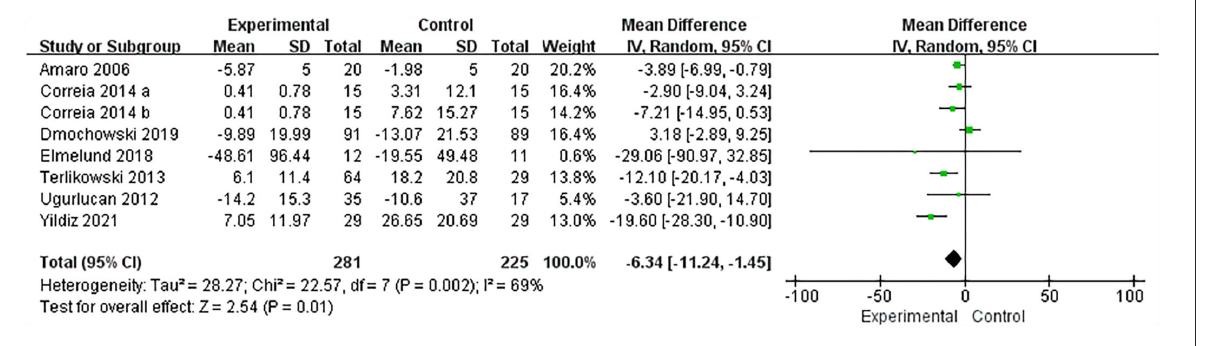
FIGURE4 Forest plots showing the improvement of pad test by IVES treatment. SD, standard deviation; IV, inverse variance; CI, confidence interval; df, degrees of